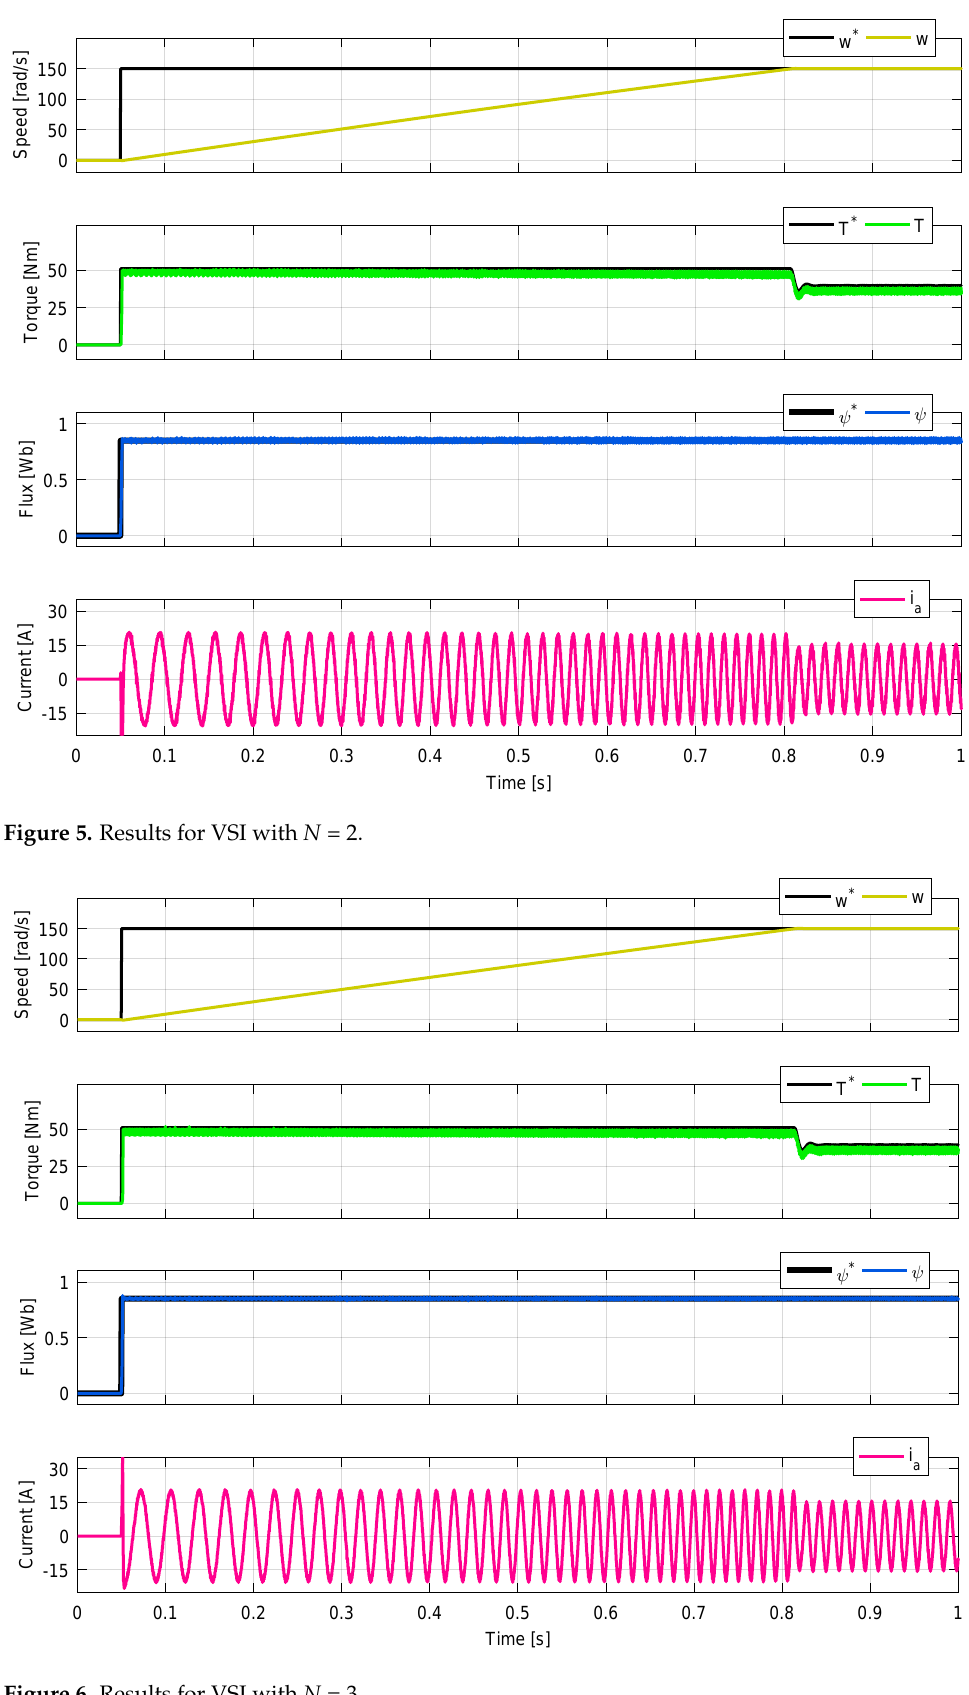
Figure 6. Results for VSI with N =